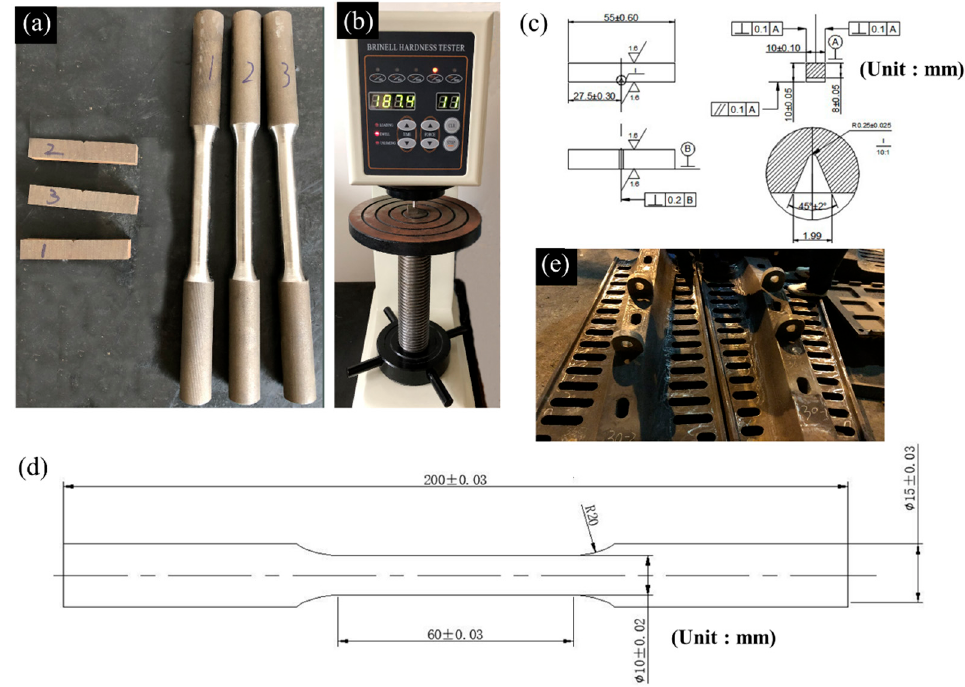
Figure 4. ( a ) Physical picture of tensile specimen and impact toughness test specimen. ( b ) Schematic diagram of hardness experiment. Drawing of impact specimen ( c ) and tensile specimen ( d ). ( e ) The physical picture of casting mill liners. Table 1. Chemical compositions of experimental steel (wt.%).